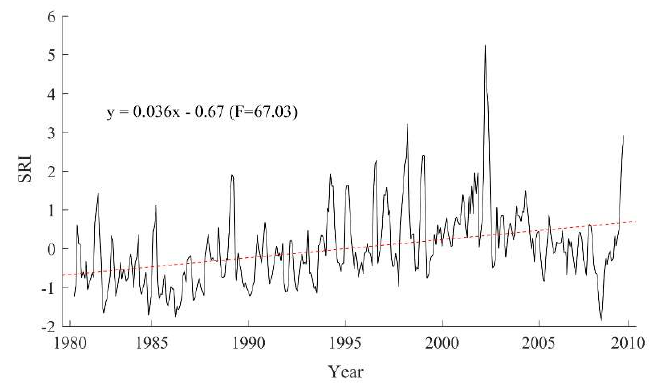
Figure 4. The time series of SRI in the ARB during 1980–2010.